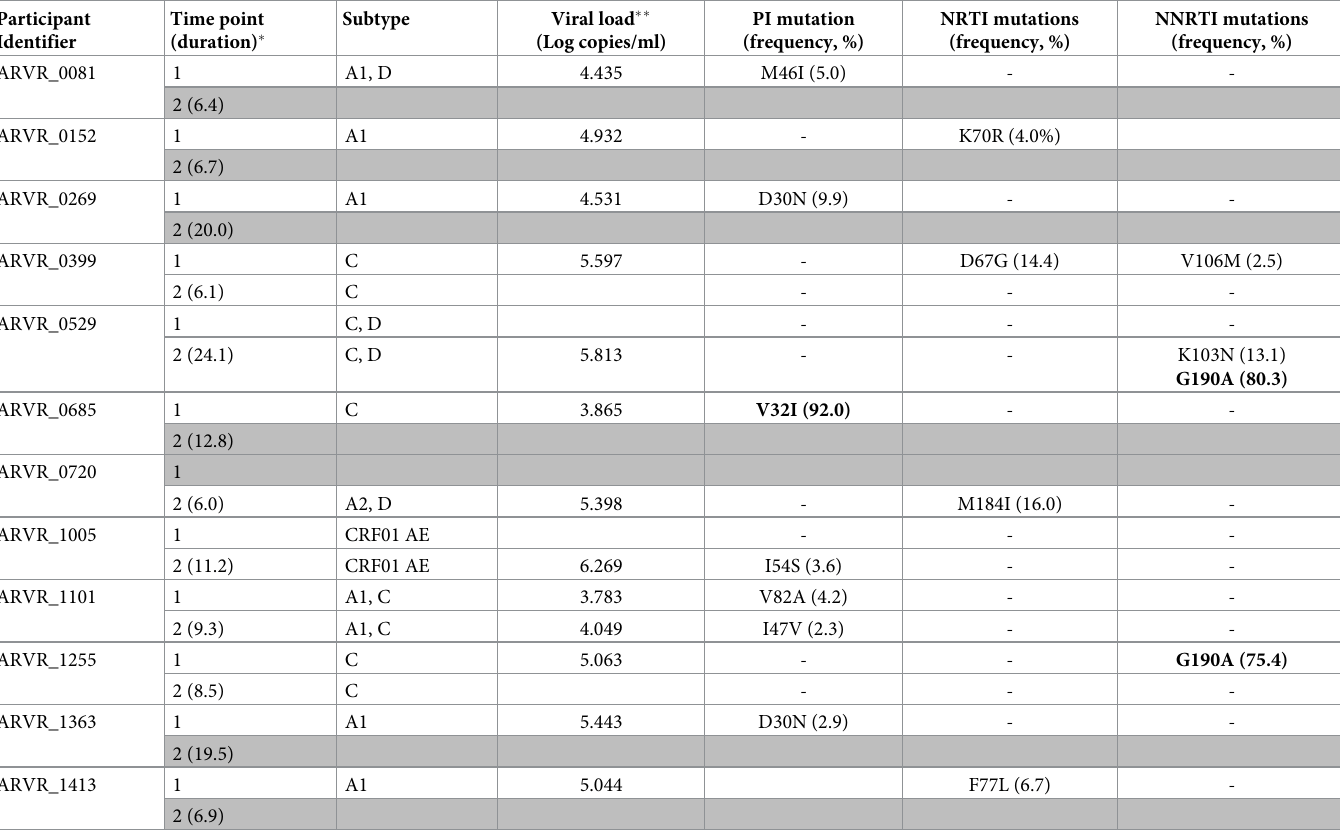
Table 3. Characteristics and distribution of participants with HIV-1 pre-treatment drug resistance variants detected by next generation sequencing in a rural HIV clinic in Coastal Kenya (N = 50).